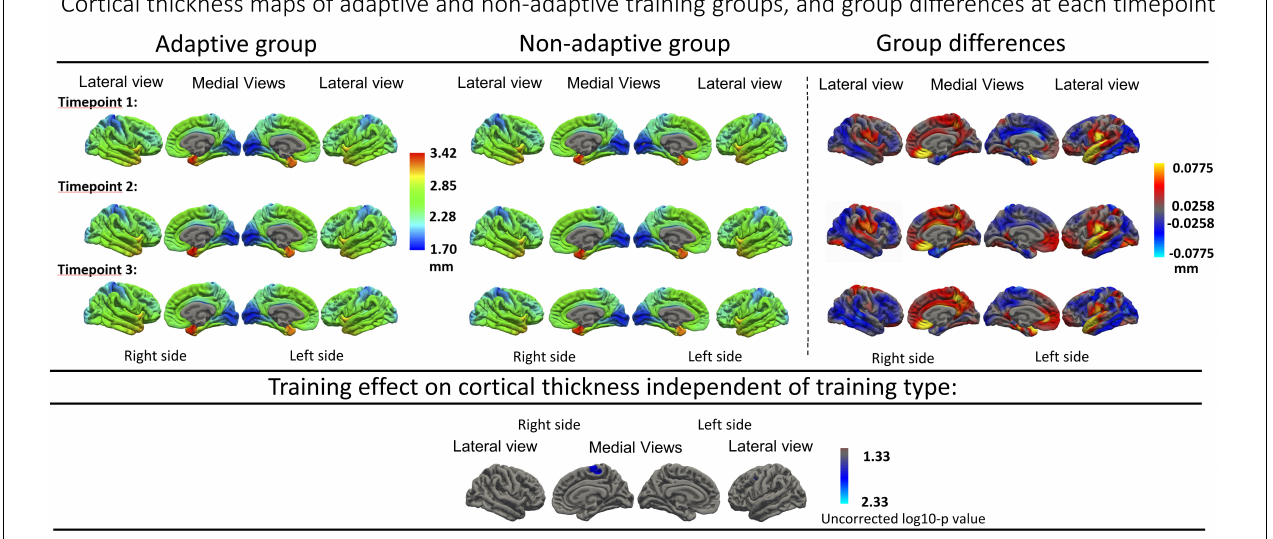
FIGURE 2 | Top panels: Average cortical thickness maps of adaptive and non-adaptive training group, with mean differences from all three timepoints. Timepoint 1: Baseline, timepoint 2: 4 weeks after training cessation. Timepoint 3: 16 weeks after training cessation. Bottom panel: Cortical thickness analysis of training effect independent of training type (time, uncorrected), show no significant region after FDR correction (significance threshold of log10-p: 2.76 = 0.0017). Resampled surface maps, were smoothed with kernel factor of 30 mm (fwhm).